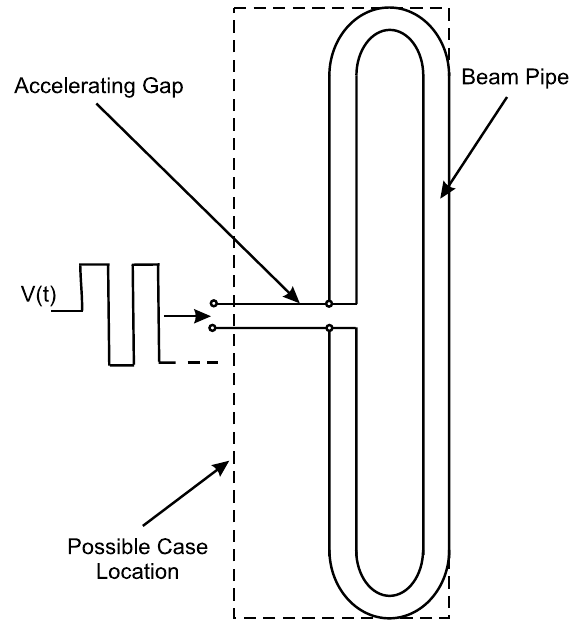
FIG. 11. Air-core recirculator without